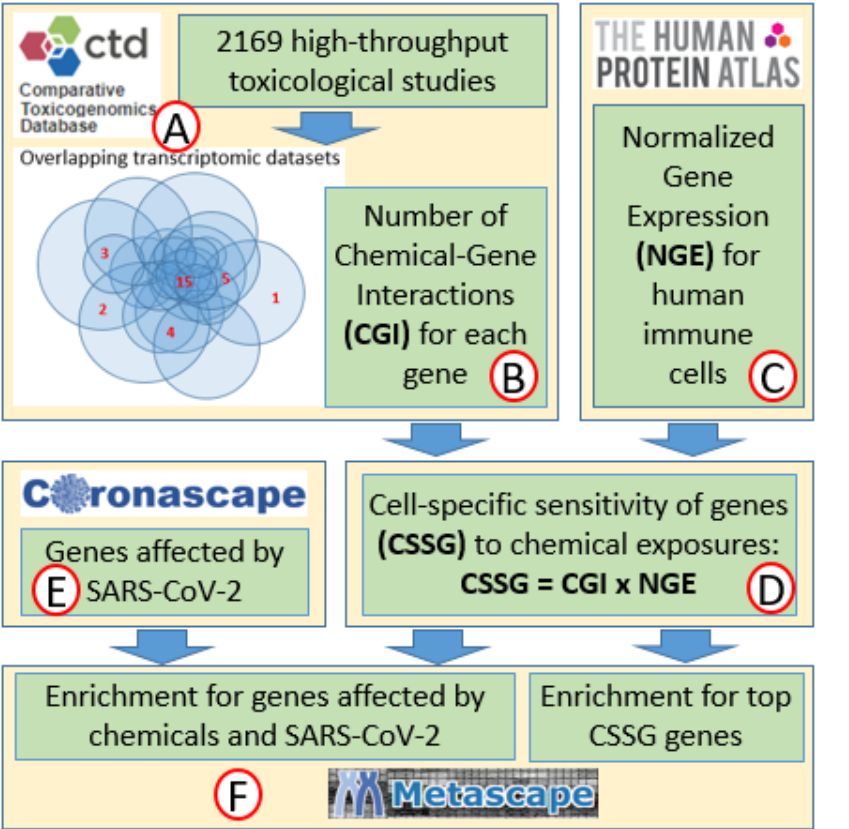
Figure 1. Flow chart of the study approach: transcriptomic information from 2169 studies was extracted from the Comparative Toxicogenomic Database ( A ) and used to calculate the sensitivity of every gene to chemical exposures ( B ) [15]. Information on the expression of every gene in different types of immune cells was extracted from the Human Protein Atlas ( C ) and used to normalize the sensitivities of genes to chemical exposures for the level of expression in different cell types ( D ). Information on changes in gene expression in different immune cells in response to SARS-CoV-2 was extracted from Coronoscape ( E ). Metascape ( F ) was used to identify molecular pathways enriched with genes highly sensitive to chemical exposures in immune cells and genes affected in these cells by both chemical exposures and SARS-CoV-2.